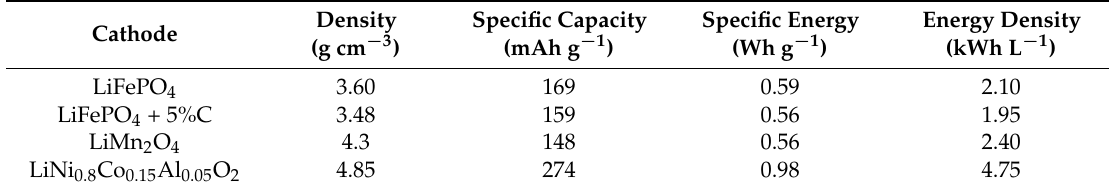
Table 1. Characteristics of active cathode materials currently used in batteries that equip electric vehicles. The specific capacities and energy densities are the theoretical values. Density Specific Capacity Specific Energy Cathode (g cm − 3 ) (mAh g − 1 ) (Wh g − 1 )